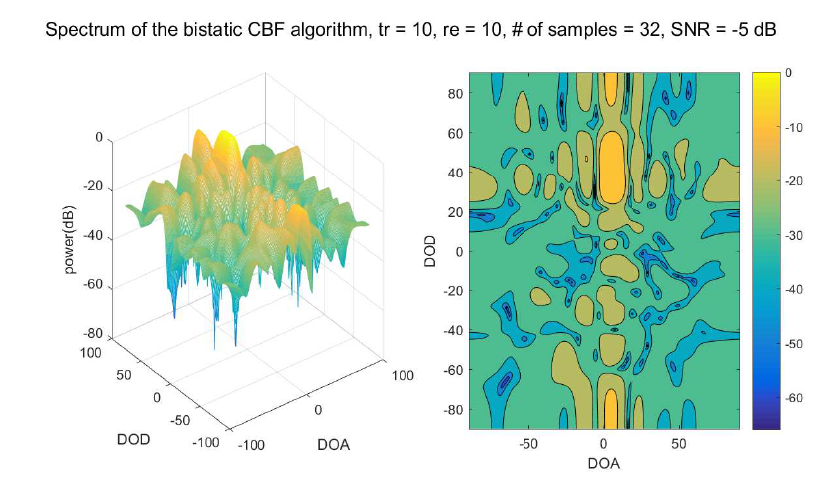
Figure 14. Spectrum of the bistatic conventional beamforming algorithm, SNR = − 5 dB.